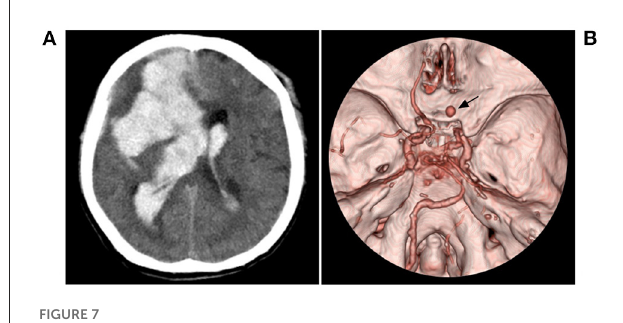
FIGURE7 Fatal hemorrhage in case 5 in Table 2. (A) CT showed hemorrhage (arrow) in the right temporal lobe involving the ventricle. (B) CTA showed an aneurysm (arrow) in the right moyamoya vessels, and bilateral MMD can be seen. CT, computed tomography; CTA, computed tomography angiography; MMD, moyamoya